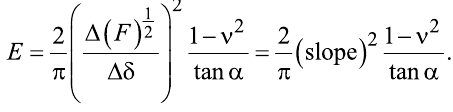
where E is the Young’s modulus, ν is the poisson ratio, α is the half-opening angle of the probe, and δ is the indentation